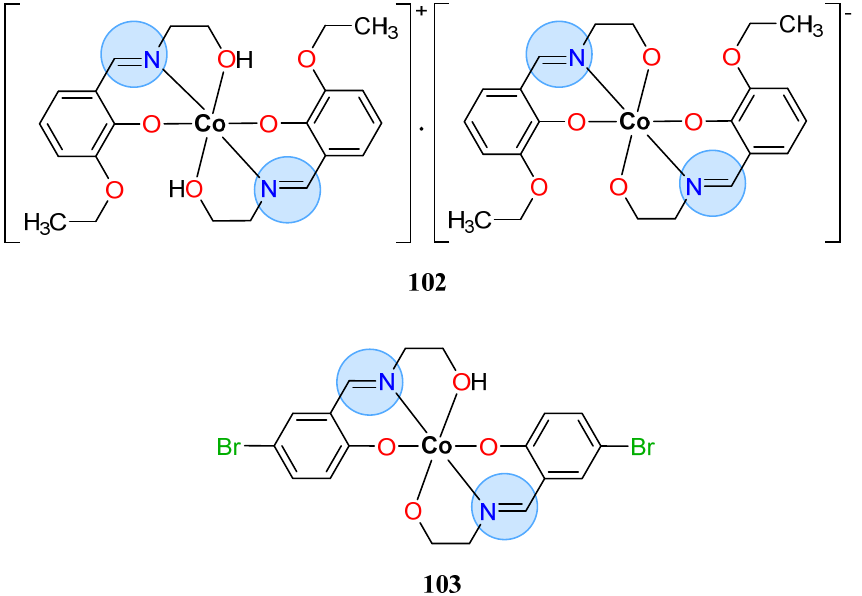
Figure 52. Cobalt complexes with Schiff base ligands (ONO) containing [(2-hydroxyethylimino)methyl]phenol studied for their antibacterial activity.